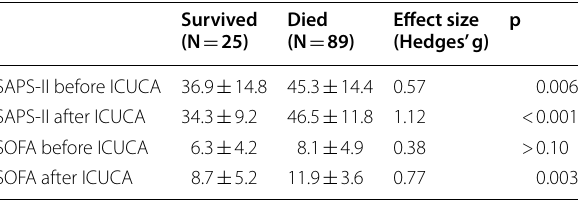
Conclusion: In our study, PK/PD of ceftobiprole was not modified in patients on ECMO and the dose of 500 mg, administered 3 times a day, allowed to obtain a trough level higher than the ceftobiprole MIC for 94% of them. Situations associated with under-dosing were renal replacement therapy and augmented renal